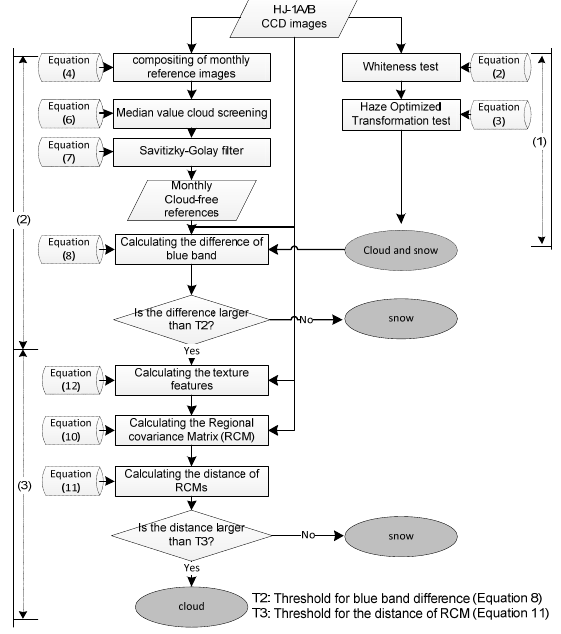
Figure 2. Flowchart of the algorithm development.